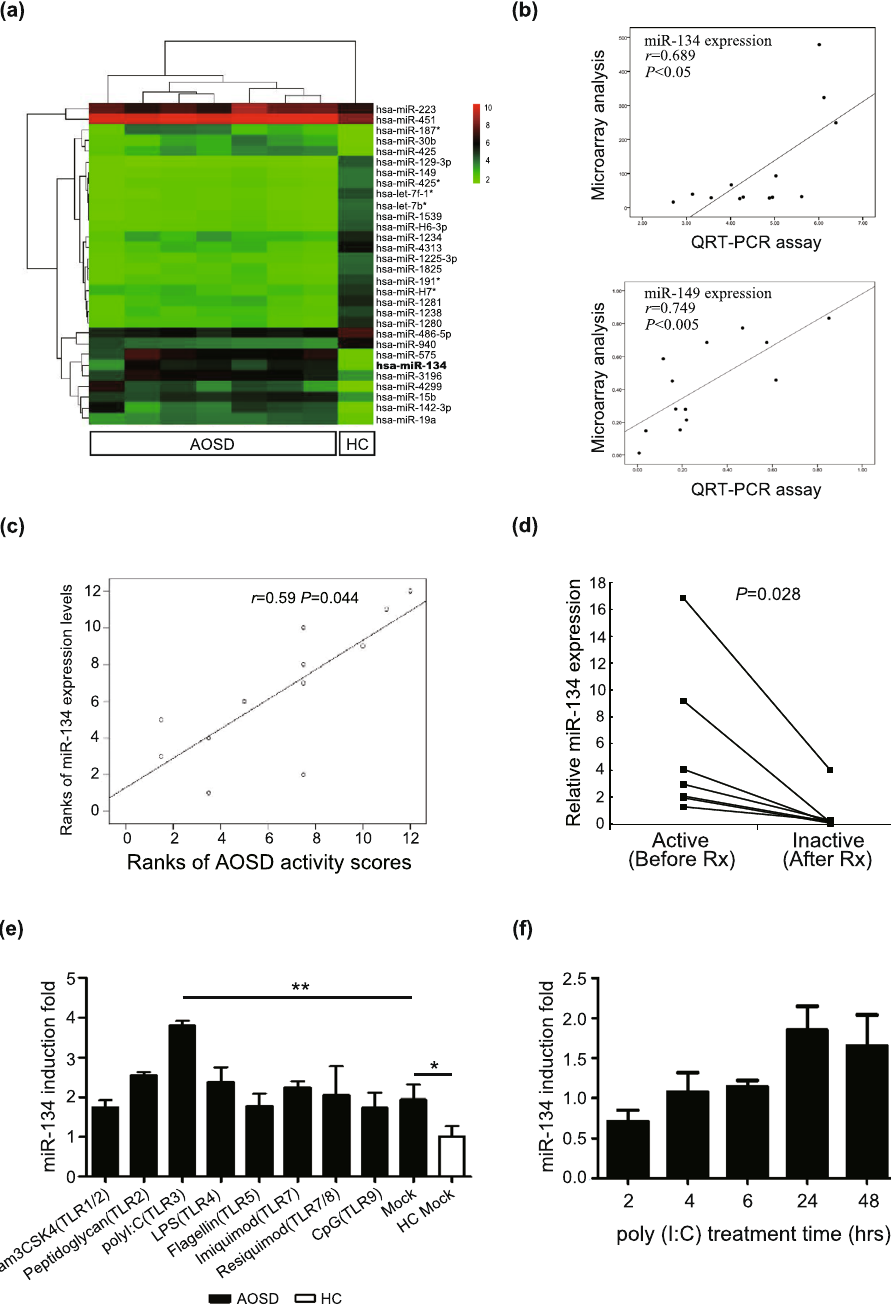
Figure 1. Increased microRNA-134 (miR-134) levels in patients with active adult-onset Still’s disease (AOSD) is associated with disease activity and induced by Toll-like receptor 3 (TLR3) ligand stimulation. ( a ) The differentially expressed microRNAs (miRNAs) in plasma from patients with AOSD and healthy controls (HC) identified using microarray analysis. Hierarchical clustering of miRNA profiles in AOSD patients group and HC group. Relative expression levels of miRNAs are depicted according to a color scale (red represents relative expression greater than the median expression level across all samples and green represents an expression level lower than the median). ( b ) Validation of miRNA microarray with quantitative reverse transcription PCR (QRT-PCR) for the two randomly selected differentially expressed miRNAs in AOSD patients. ( c ) A significant correlation between disease activity and miR-134 expression determined by QRT-PCR assay in AOSD patients. ( d ) Significant decreases in miR-134 expression levels paralleled the clinical remission in AOSD patients after 6 months of therapy. ( e ) Analysis of miR-134 expression in response to a panel of innate immunity Toll-like receptors (TLRs) ligands stimulation. The peripheral blood mononuclear cells (PBMCs) from patients with AOSD were treated with the indicated stimuli for 24 h. MiR-134 expression was analyzed by QRT-PCR and normalized using Rnu6 levels. (f) Kinetics of TLR3 ligand induction of